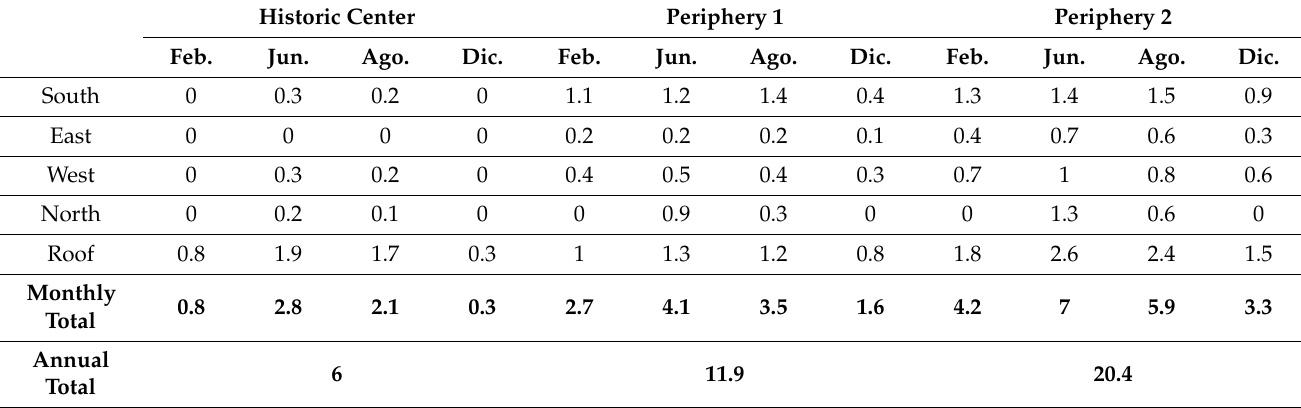
Figure 8. Results of accumulated hours of sunlight per day in the four days of measurement. Table 2 shows the wide difference in direct sunlight between the study samples. Overall, the case of the historic center has very low lighting values, and the roof is the only area of the building with a noticeable sunlight reception all year around. The low receives more hours of sun in the northern hemisphere. Table 2. Hours of direct sunlight per square meter of façade surface, considering the orientation of the façade on four days of the